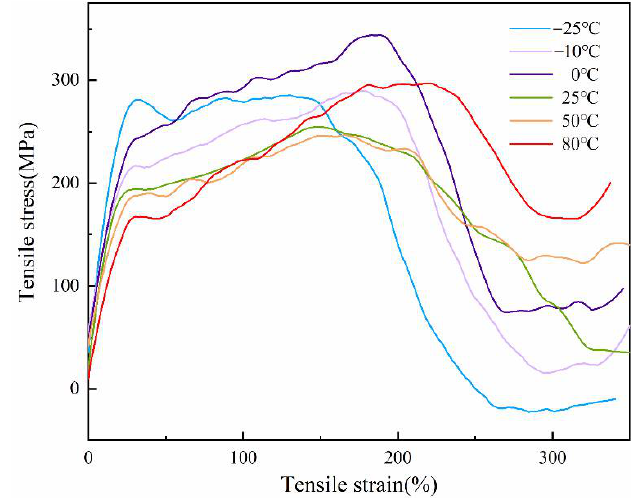
Figure 9. Stress-strain curves of the PCTF at different temperatures.